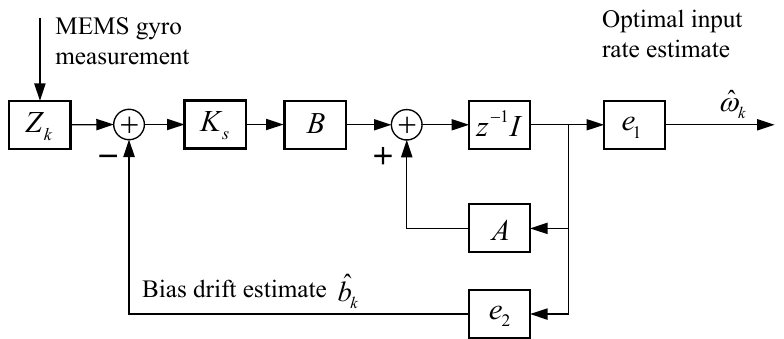
Figure 2. Angular rate signal implement and estimate using a discrete KF.